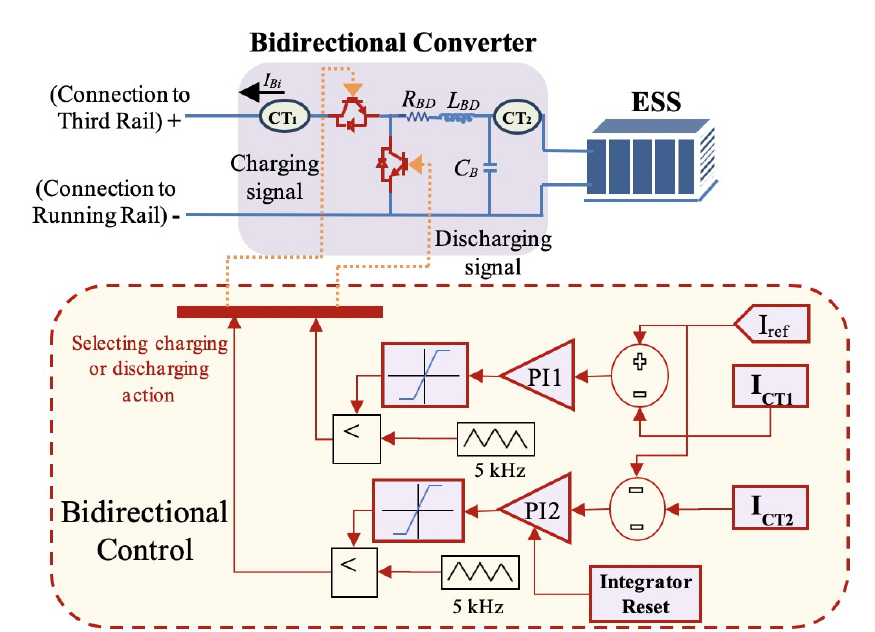
Figure 6. Simulation model of train.